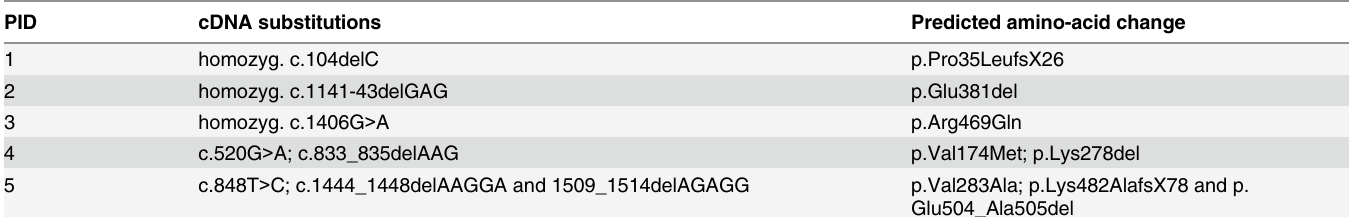
Table 2. Mutation analysis of